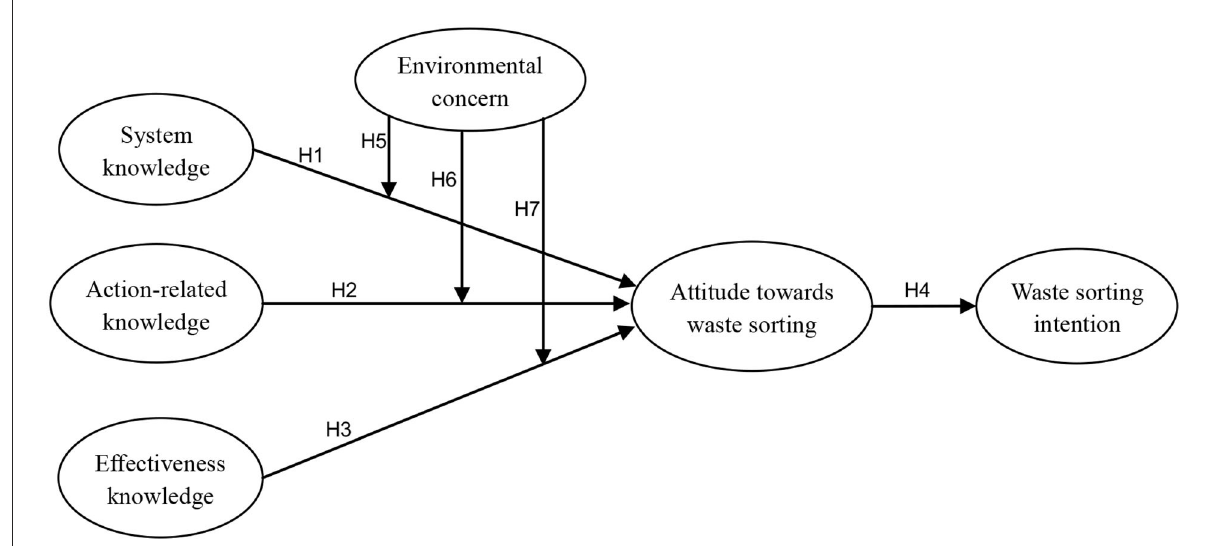
FIGURE1 Research model.